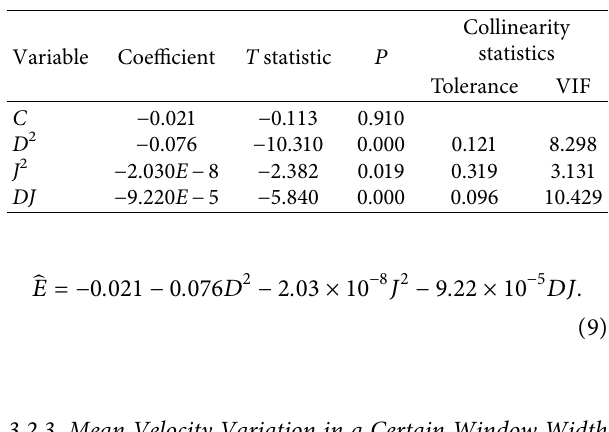
Figure 13: Three-dimensional graph of velocity variation error- mean absolute acceleration slope-discrimination threshold re- gression equation. Table 12: Significance of coefficients of the adjusted model (mean velocity variation in a certain window